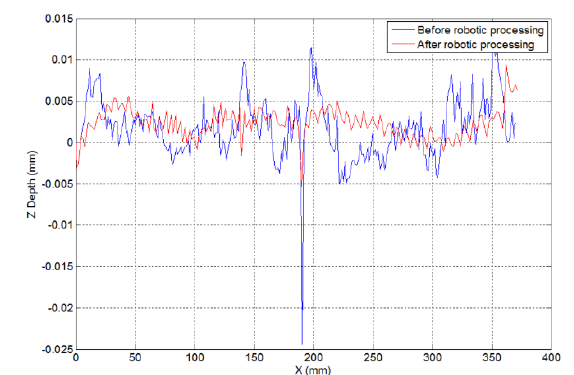
Fig. 5. Calibration of material removal.